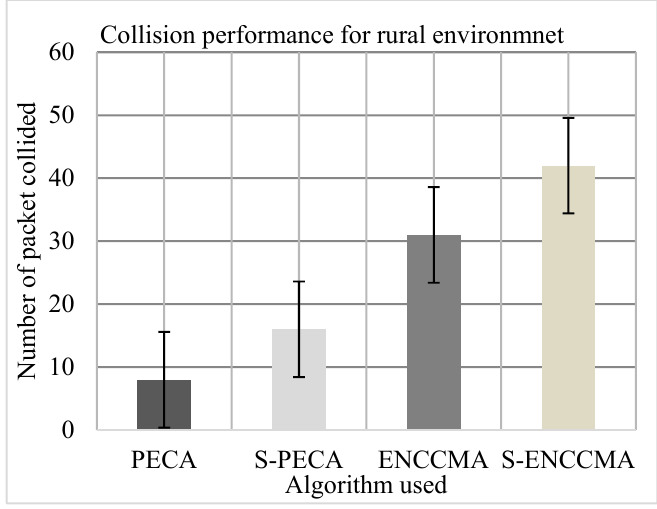
Figure 12. Collision performance for the rural environment.